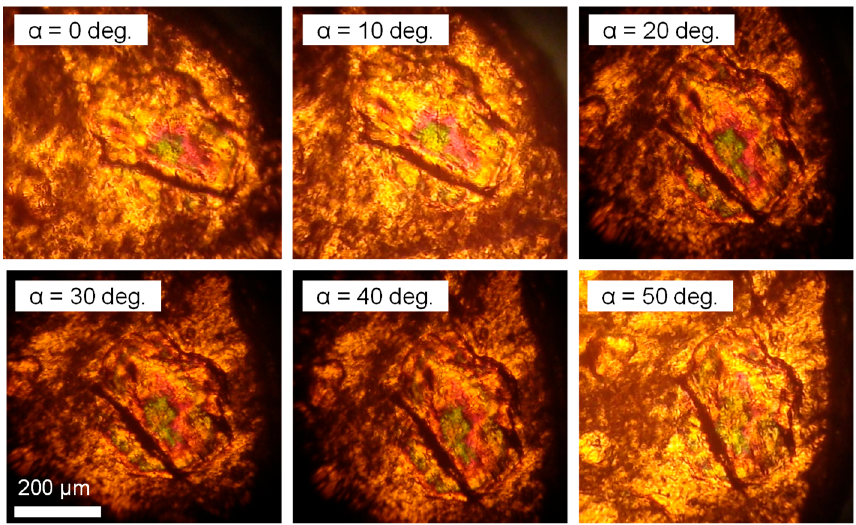
Figure 6. Images of the Co 2 Al–CO 3 LDH compact (the same sample that shown in Figure 5a) in crossed polarizers. The turning angles of the sample in the microscope stage ( α ) are indicated.